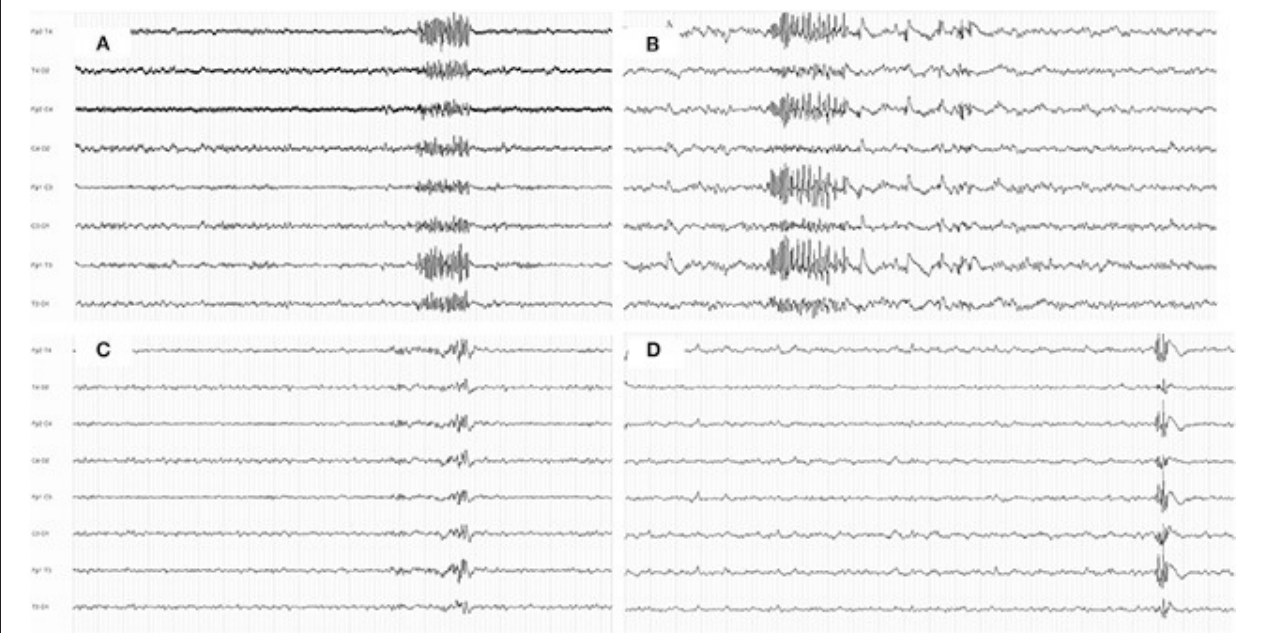
FIGURE 1 | Examples of generalized fast discharges during sleep. (A,B) Examples of generalized paroxysmal fast activity in two patients (A) undefined genetic generalized epilepsy; (B) perioral myoclonia with absences; (C,D) examples of generalized polyspike train in two patients; (C) juvenile myoclonic epilepsy; (D) childhood absence